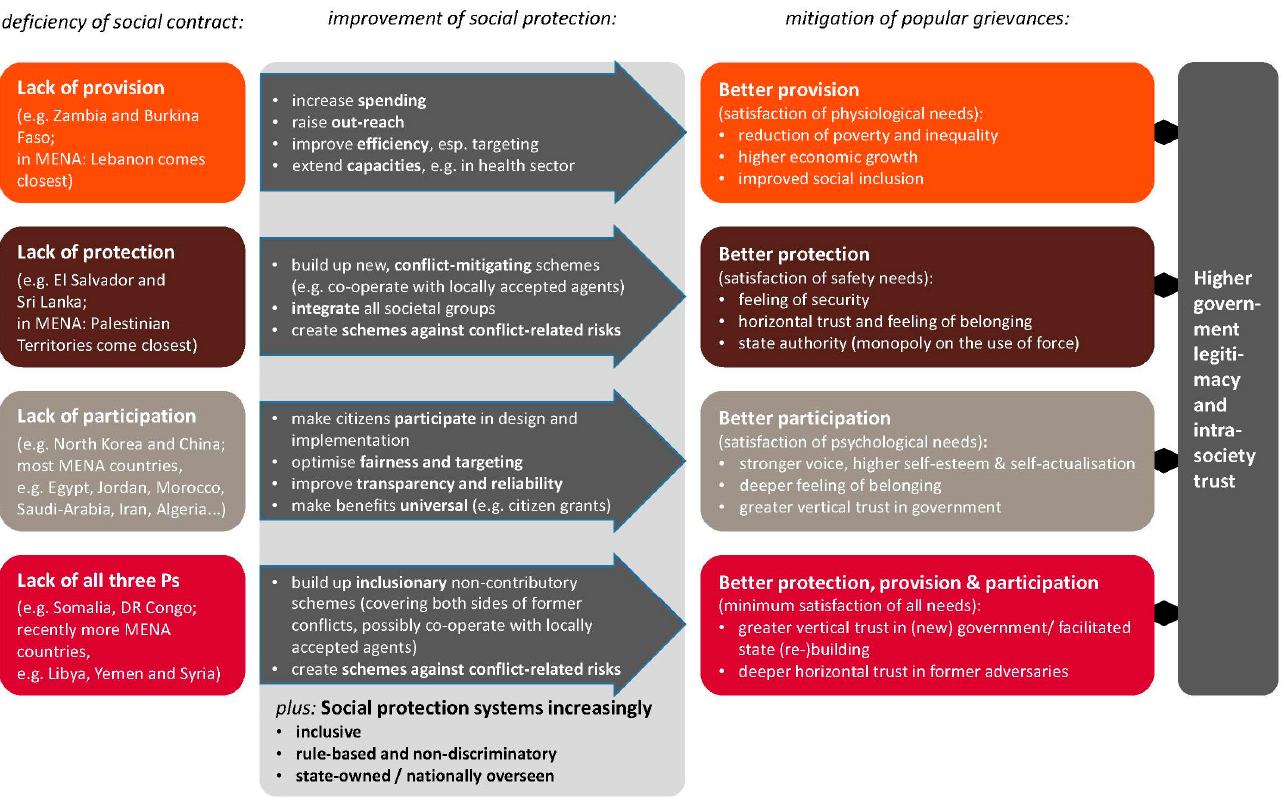
Figure 2. Social protection as a remedy of popular grievances within deficient social contracts. Source: authors.